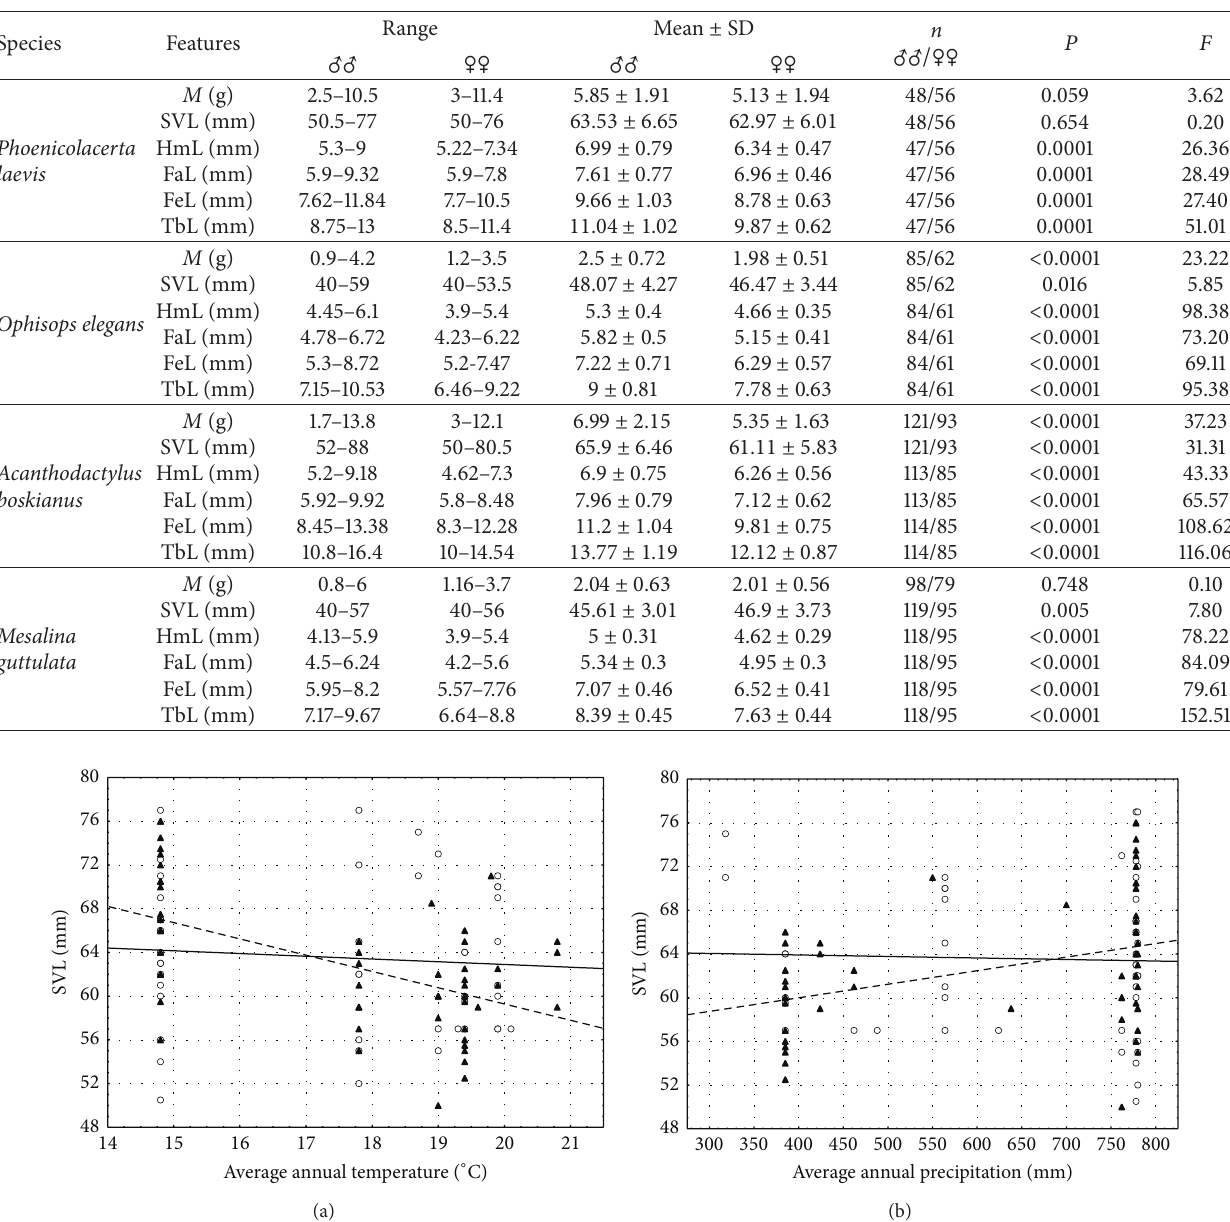
Table 1: Morphological characteristics of lizard species studied and their intersexual comparisons (one-way ANOVA with multiple testing corrections; Duncan’s multiple range test, MRT).